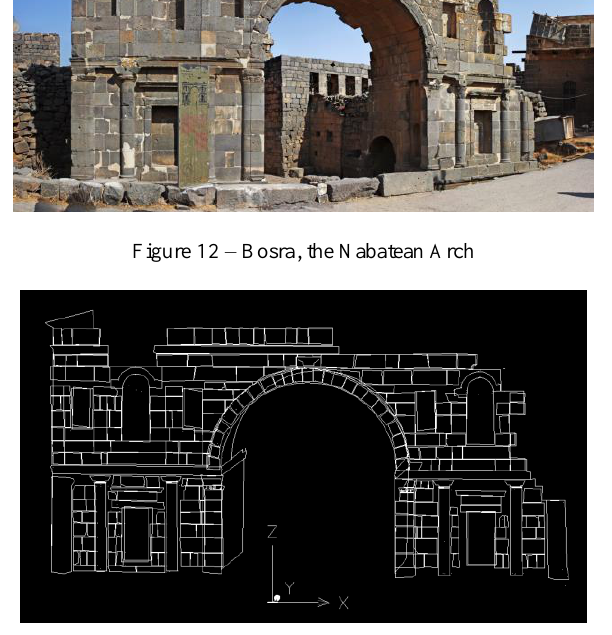
Figure 13 – The Nabatean Arch (plot by P. Biagiola) with five panoramas